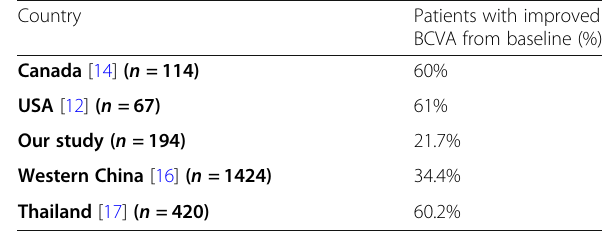
Table 12 Final visual outcomes compared to other countries. Only 21.7% of patients in our study had improved BCVA upon